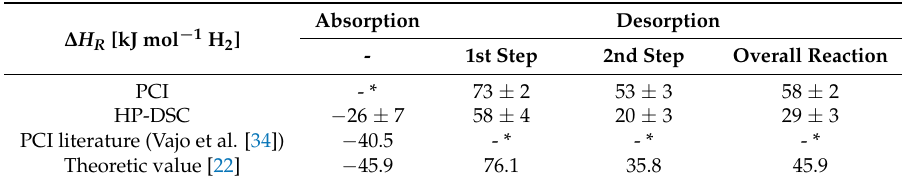
Table 2. Comparison of the reaction enthalpy ∆ H R values of the Li-RHC system obtained from different sources.